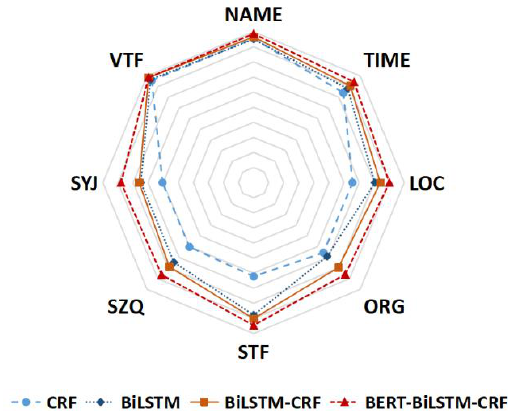
Figure 7. F1 scores of different event-elements on different models.